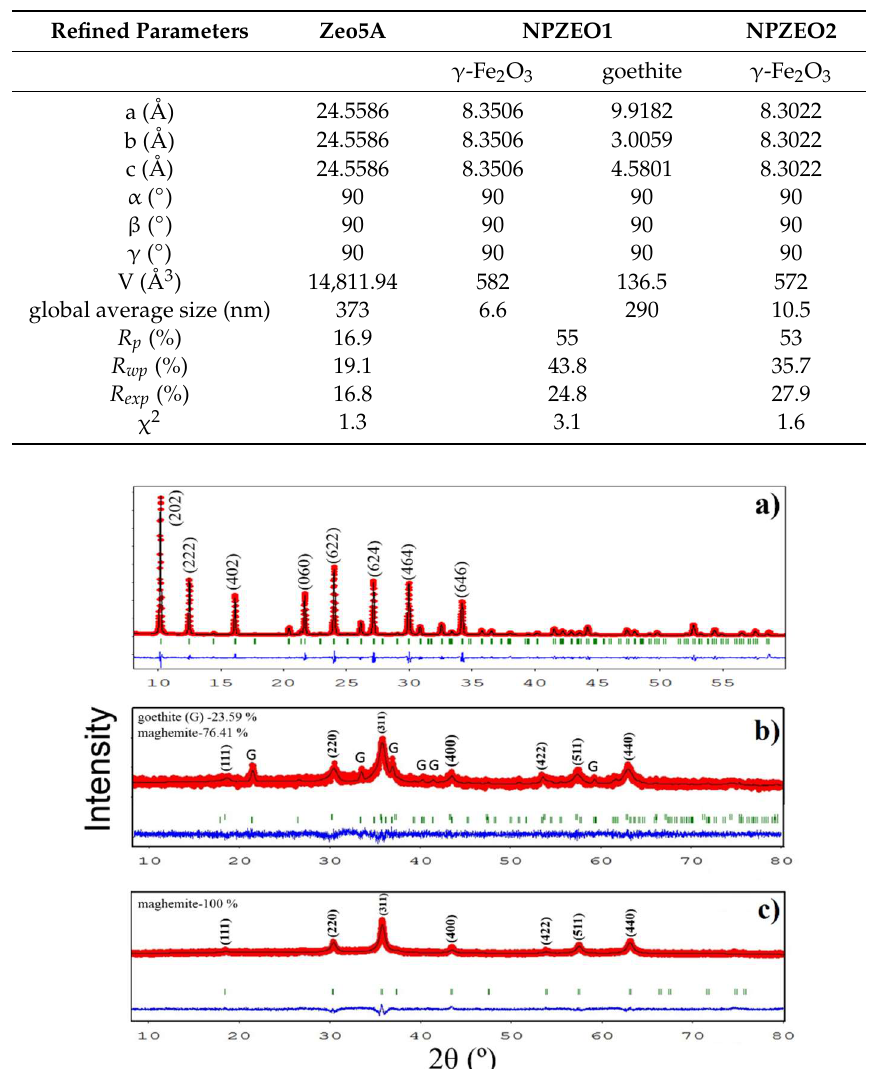
Figure 1. X-ray di ff raction (XRD) patterns with their Rietveld refinements for zeolite type 5A ( a ), NPZEO1 ( b ), and NPZEO2 ( c ) samples. The observed experimental di ff ractograms are given by the red lines (I obs ), the black lines (I cal ) are calculated di ff ractograms, and the residual lines are shown in blue color. G represents goethite phase and Bragg’s peak positions are indicated with green vertical bars.